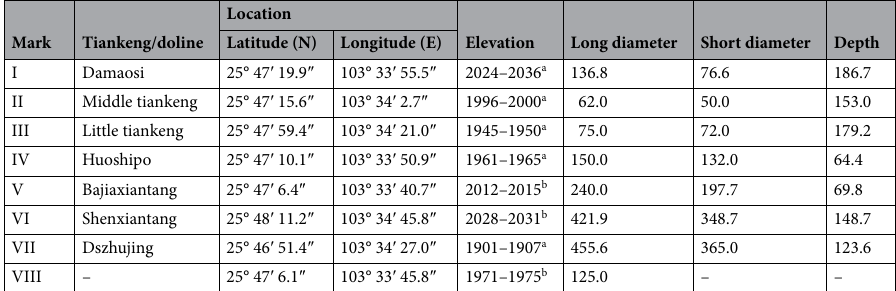
Table 6. Basic information of karst tiankengs and dolines (m), “a” showed the elevation data measured in the edge of tiankeng/dolines; “b” showed the elevation data measured in the bottom of